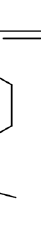
Figure 2. Chemical structure of β -elemene.